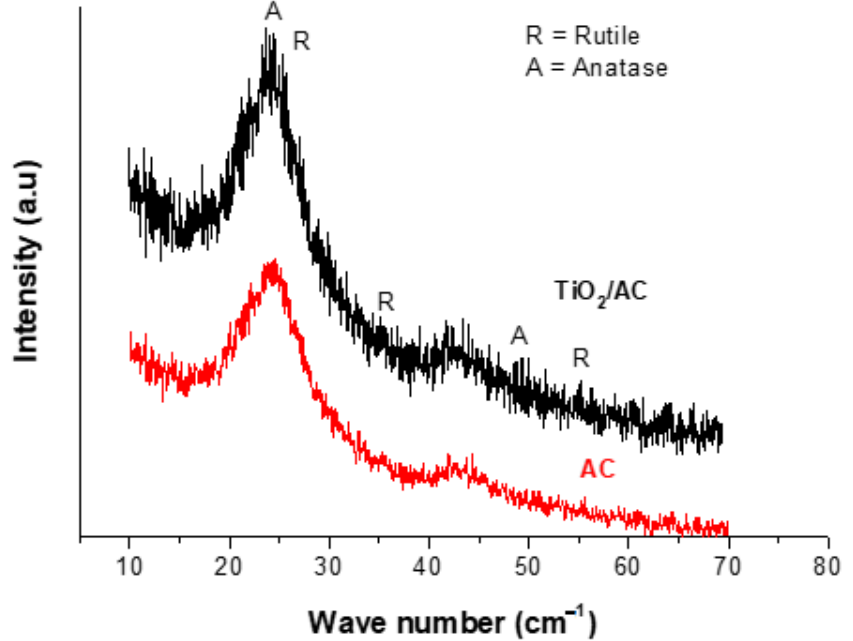
Figure 3. XRD Pattern of AC and TiO 2 /AC.